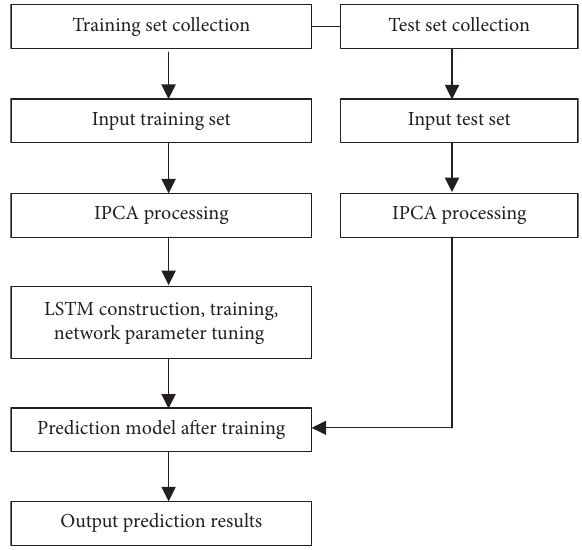
Figure 2: Flow chart of power generation prediction by IPCA combined with